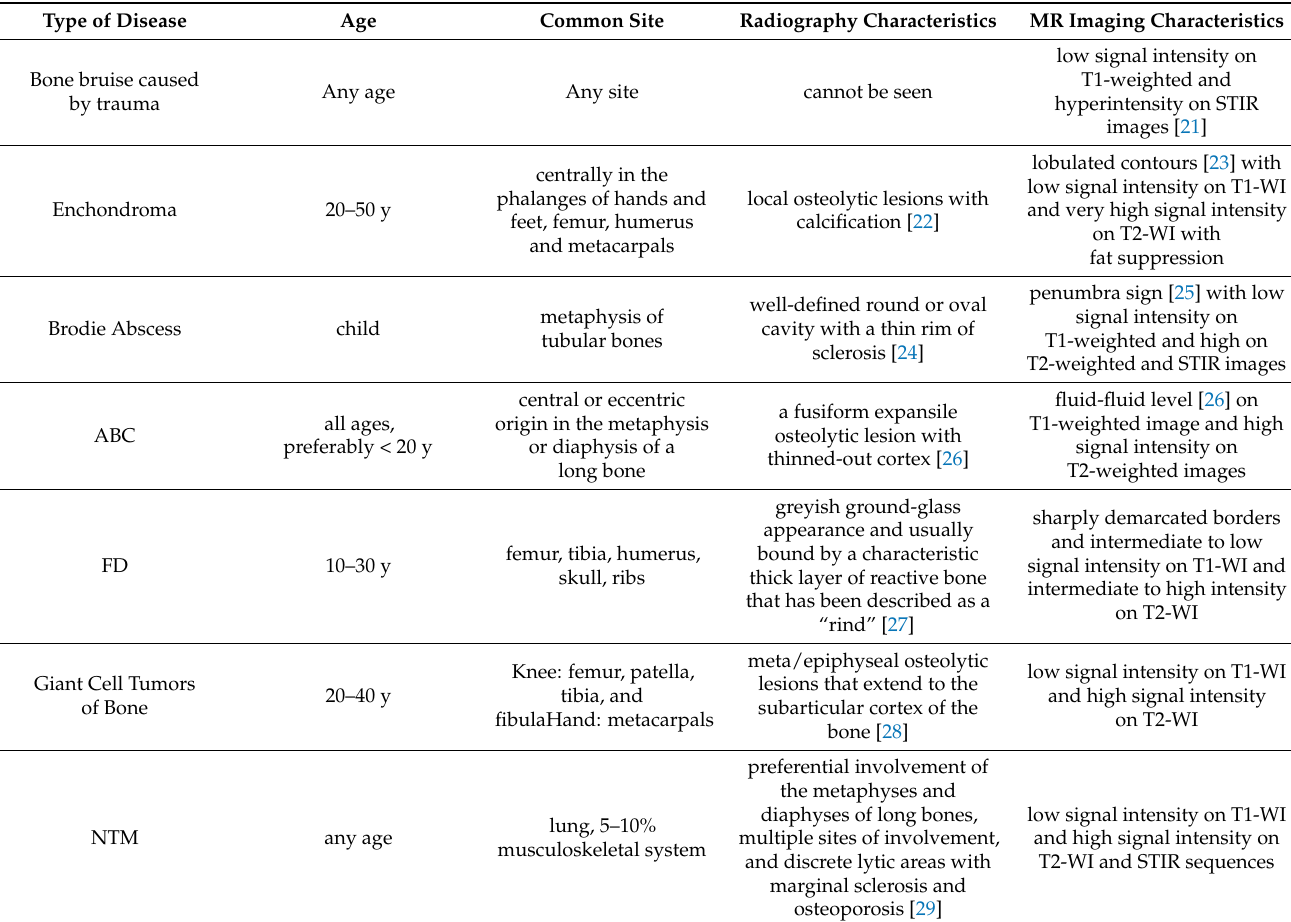
Table 3. Differential